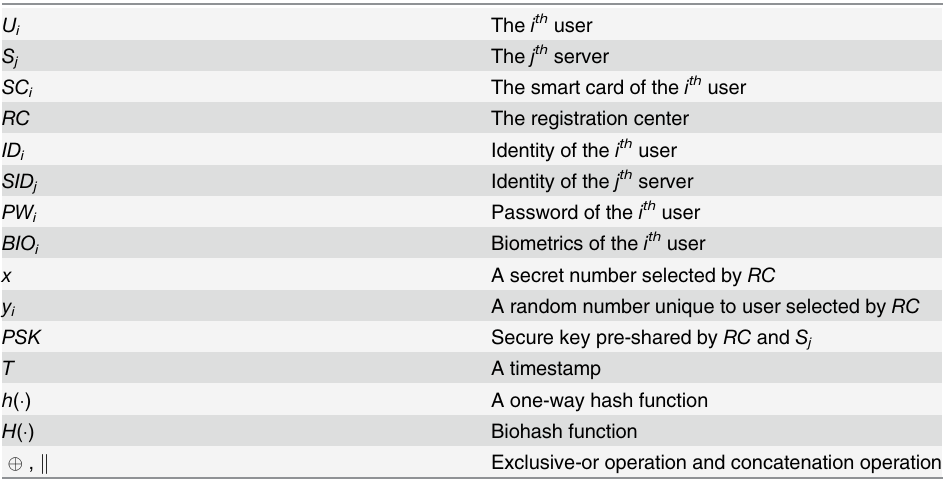
Table 2. Notations used in our proposed